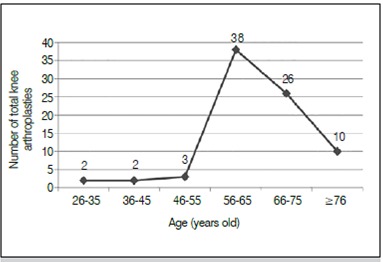
Number of total knee arthroplasties performed by age groups in 2013-2014.